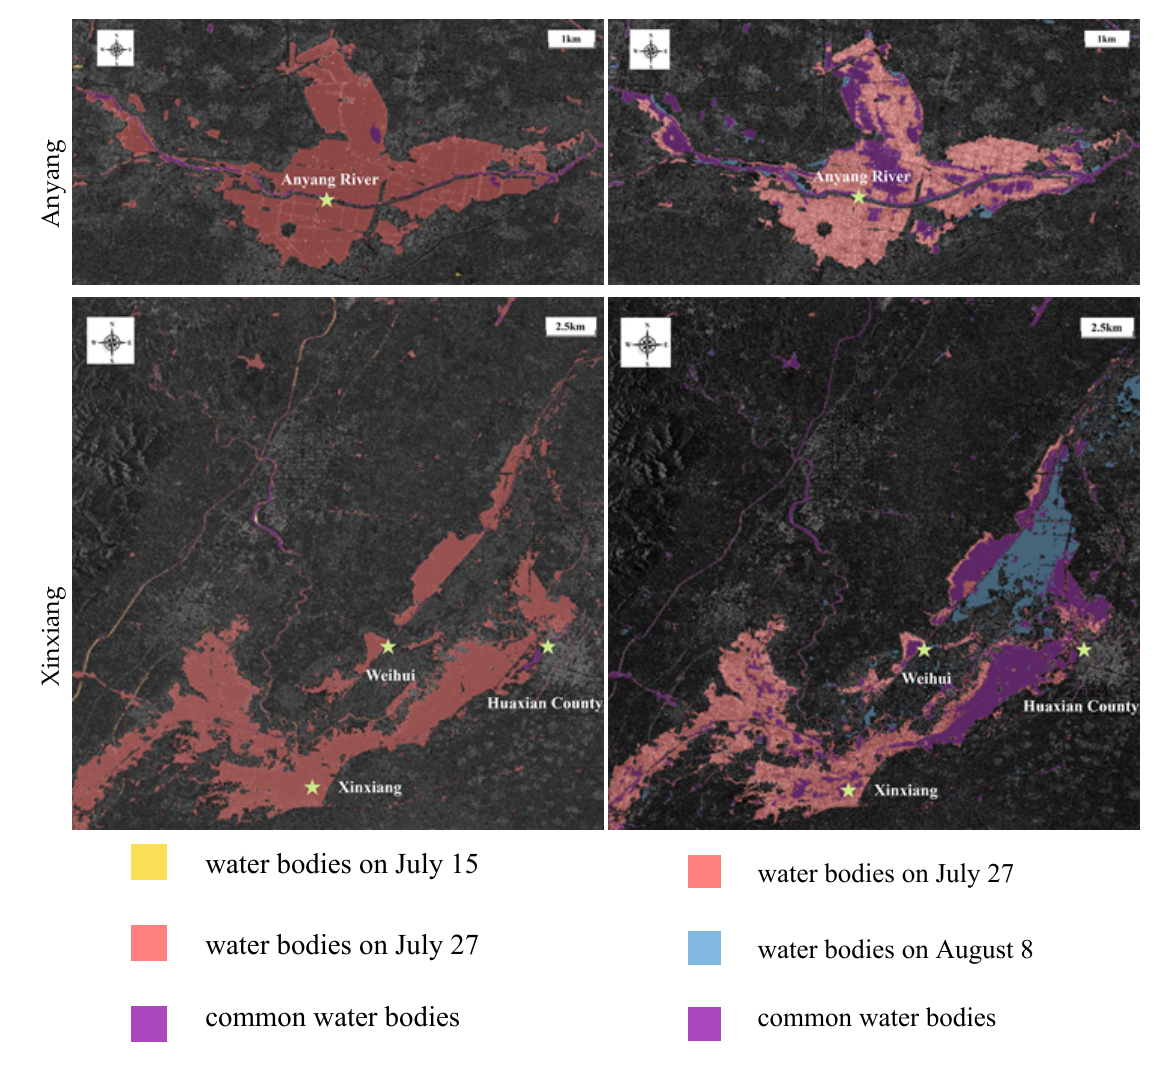
Figure 13. The color-coded maps of flood detection results. The first column shows the change maps between 15 July and 27 July. The second column shows the change maps between 15 July and 8